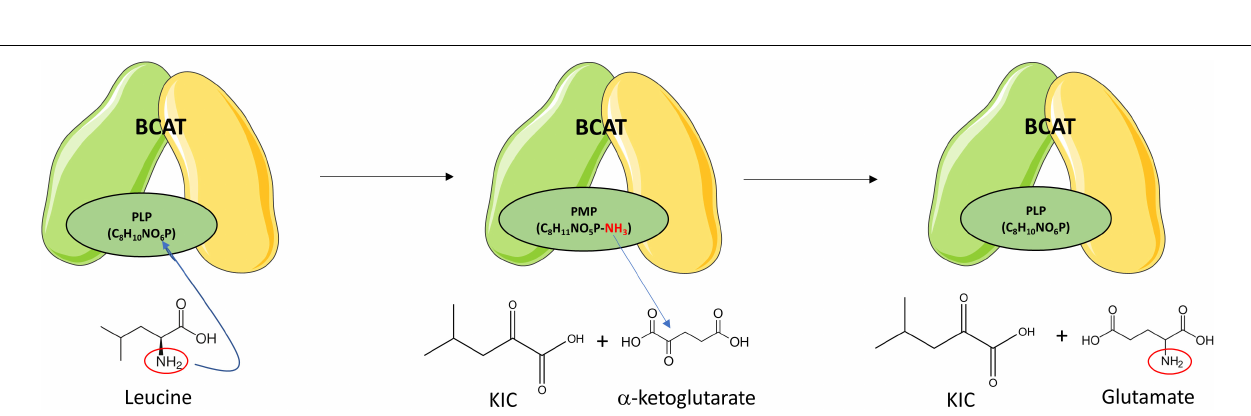
FIGURE 4 | Branched-chain amino transferase reaction. BCAT catalyzes the reversible transamination of branched-chain amino acids (BCAAs) into their respective branched-chain ketoacids (BCKAs). Leucine is transaminated to ketoisocaproic acid (KIC), isoleucine to keto-beta-methylvaleric acid (KMV), and valine to ketoisovaleric acid (KIV). The α -amino group of the BCAA is transferred to BCAT-PLP yielding BCAT-pyridoxamine phosphate (PMP) and the respective BCKA. The α -amino group is then transferred from the BCAT-PMP to α -ketoglutarate producing glutamate and restoring BCAT-pyridoxal phosphate (PLP). Leucine transamination is shown as representative of transamination reactions of the other BCAAs. Re-drawn and modified from Conway and Hutson (2016).